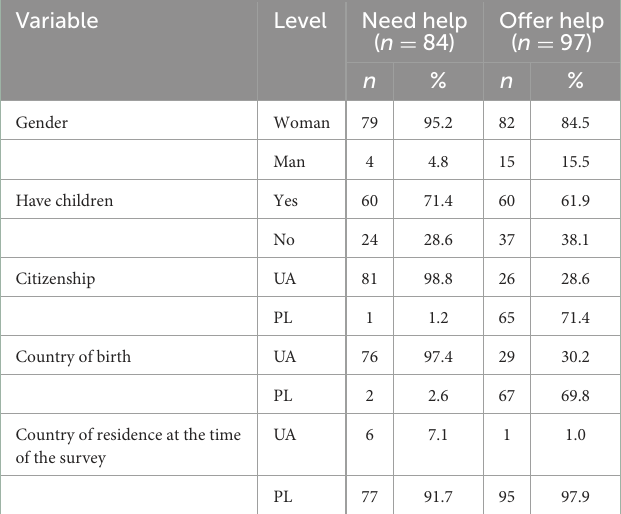
TABLE 4 Descriptive statistics of people in need of help and people providing aid.